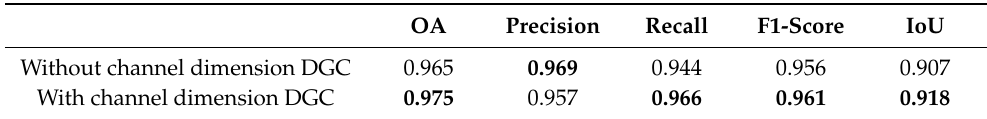
Figure 16. Comparison of the BGC-Net with or without the channel dimension DGC part on the WHU dataset. ( a ) Original image. ( b ) Ground truth. ( c ) Without channel dimension DGC. ( d ) Without channel dimension DGC. Note, in Columns ( b – d ), black, white, green, blue, and red indicate true, false, true-positive, false-negative, and false-positive, respectively. Table 6. Average accuracy of the BGC-Net with or without the channel dimension DGC part on the WHU dataset. The best scores are highlighted in bold.